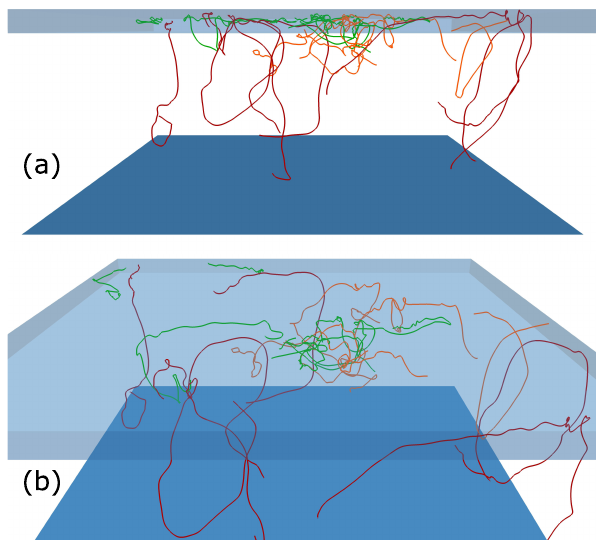
Figure 2. Trajectories of Lagrangian cloud droplets from two dif- ferent viewing points. The droplets have been tracked during 1 . 2 t ∗ . The upper blue box in each figure represents the cloud-top region where the radiative cooling is strongest, and has a vertical extent of 2 λ . The lower blue plane represent cloud base, which is placed 20 λ = 300m below cloud top. A strong stratification limits the flow at cloud base. The trajectories are sorted into three categories (green, red, and orange) that are described in the